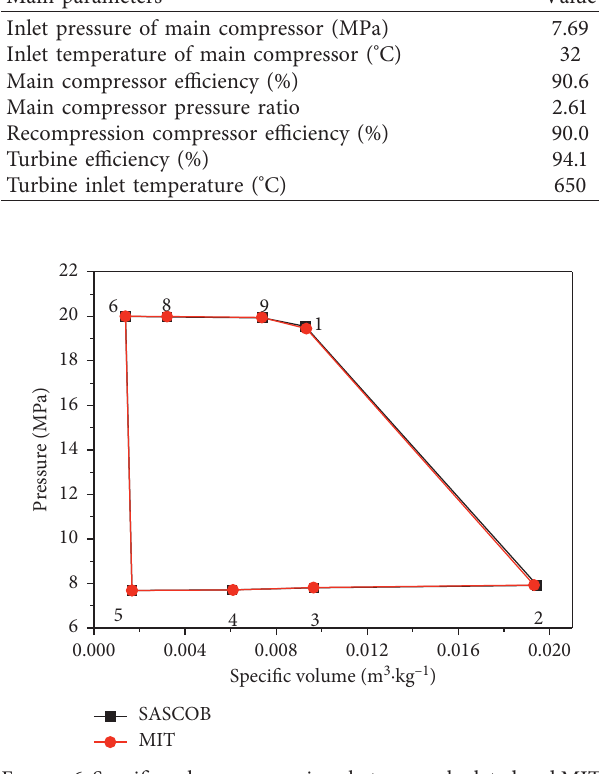
Figure 6: Specific volume comparison between calculated and MIT design values.